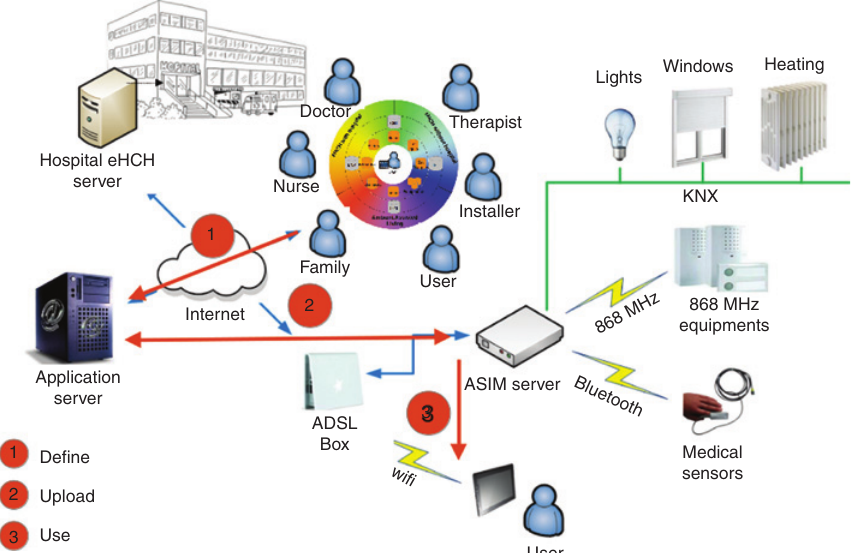
Figure 2: Global Architecture with the Application Server (Application Generator) and the ASIM Server (Applications and Home